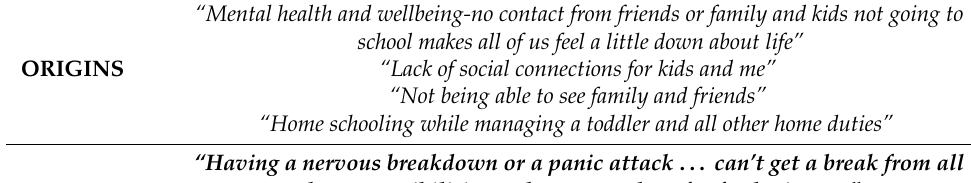
Table 3. Mental health/social isolation: Sample responses.